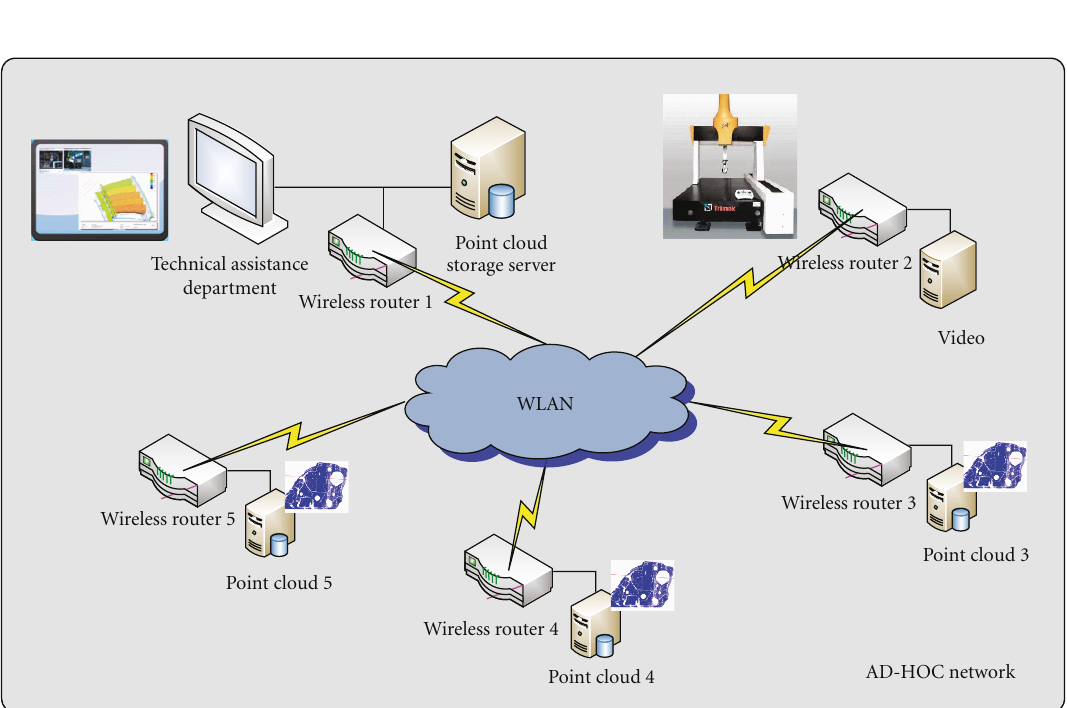
Figure 1: LOOP scenario.